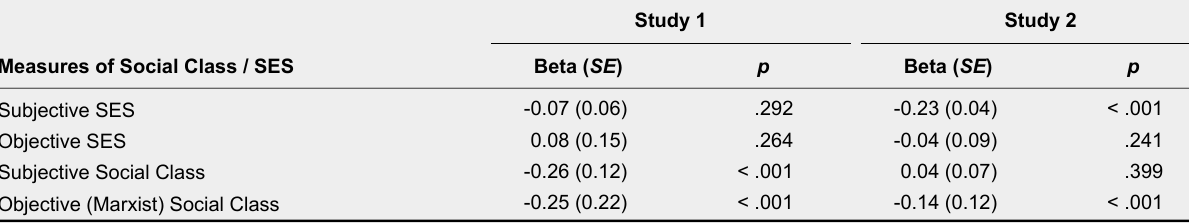
Regression of Alienation on Measures of Social Class and